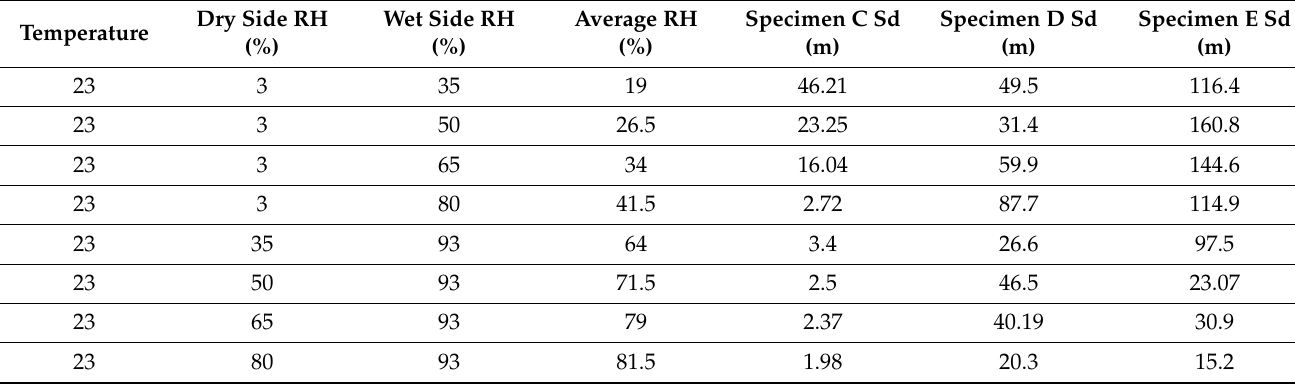
Table 5. Equivalent air layer thickness with different boundary